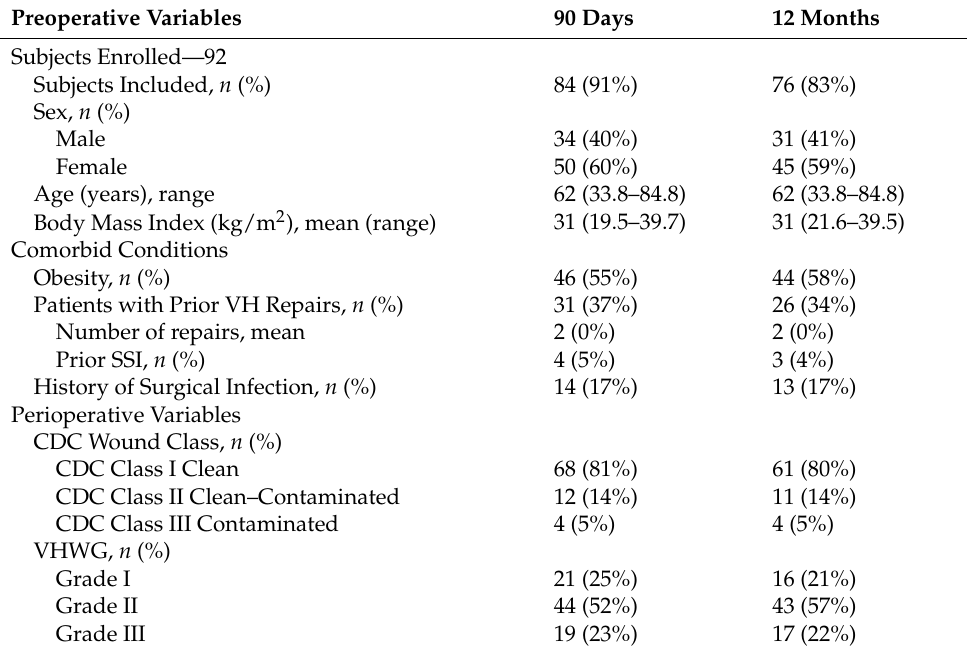
Table 1. Preoperative Variables, Comorbid Conditions, and Perioperative